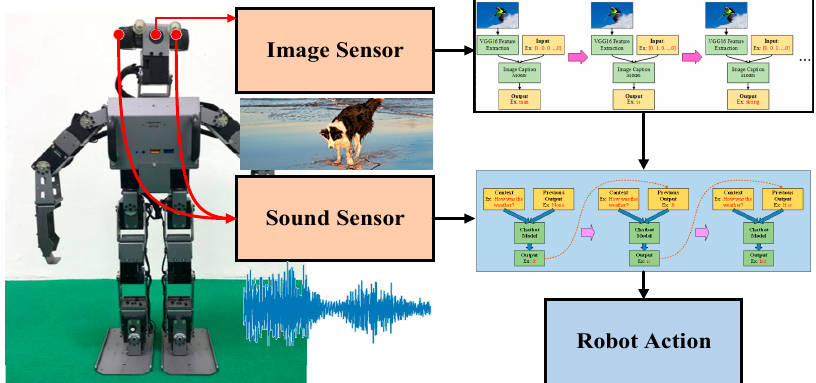
Figure 1. An overview of the proposed framework.